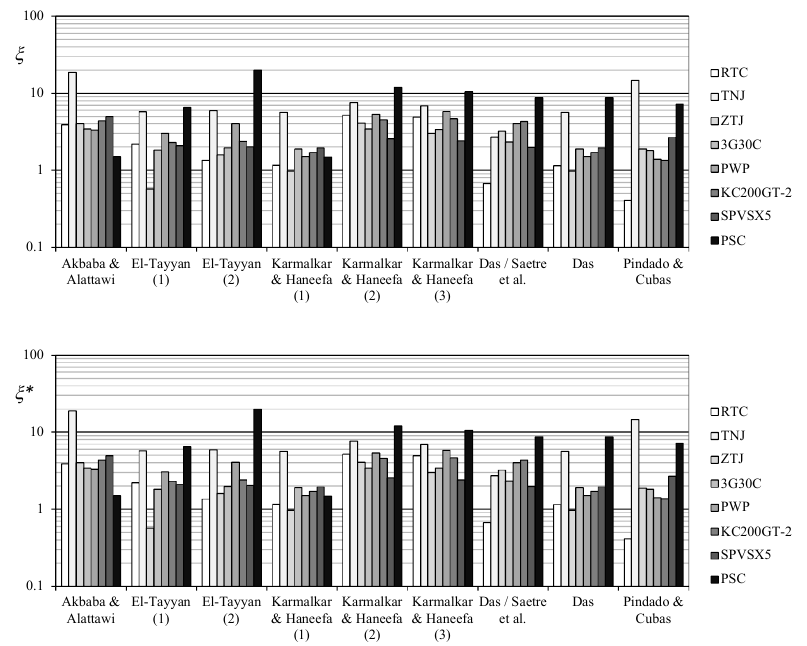
Figure 12. Comparison of the different explicit models studied, analytically fitted to the I – V curves selected for the benchmark (Table 2). Normalized RMSE, ξ , (Equation (37)), and normalized RMSE within ±5% of V oc around the maximum power point, ξ *. See also Tables 3–8. El-Tayyan (1) indicates Equation (13), whereas El-Tayyan (2) refers to Equation (18). Karmalkar & Haneefa (1) indicates Equation (20), Karmalkar & Haneefa (2) refers to Equation (22), and Karmalkar & Haneefa (3) indicates Equation (24).